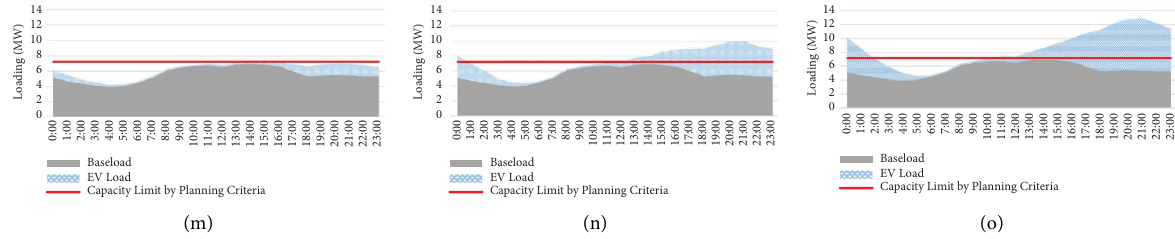
Figure 14: Capacity loading of fve primary feeders under the three scenarios of EV penetration for uncoordinated charging. Primary feeder no. 1 with (a) 10%, (b) 30%, and (c) 50% EV penetration. Primary feeder no. 2 with (d) 10%, (e) 30%, and (f) 50% EV penetration. Primary feeder no. 3 with (g) 10%, (h) 30%, and (i) 50% EV penetration. Primary feeder no. 4 with (j) 10%, (k) 30%, and (l) 50% EV penetration. Primary feeder no. 5 with (m) 10%, (n) 30%, and (o) 50% EV